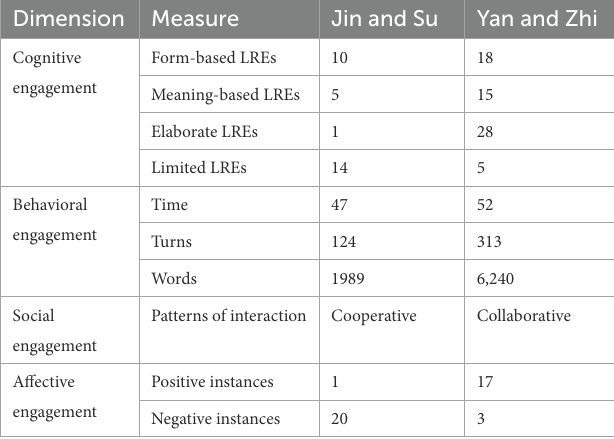
TABLE 8 Comparison of EWT between Jin and Su and Yan and Zhi. Dimension